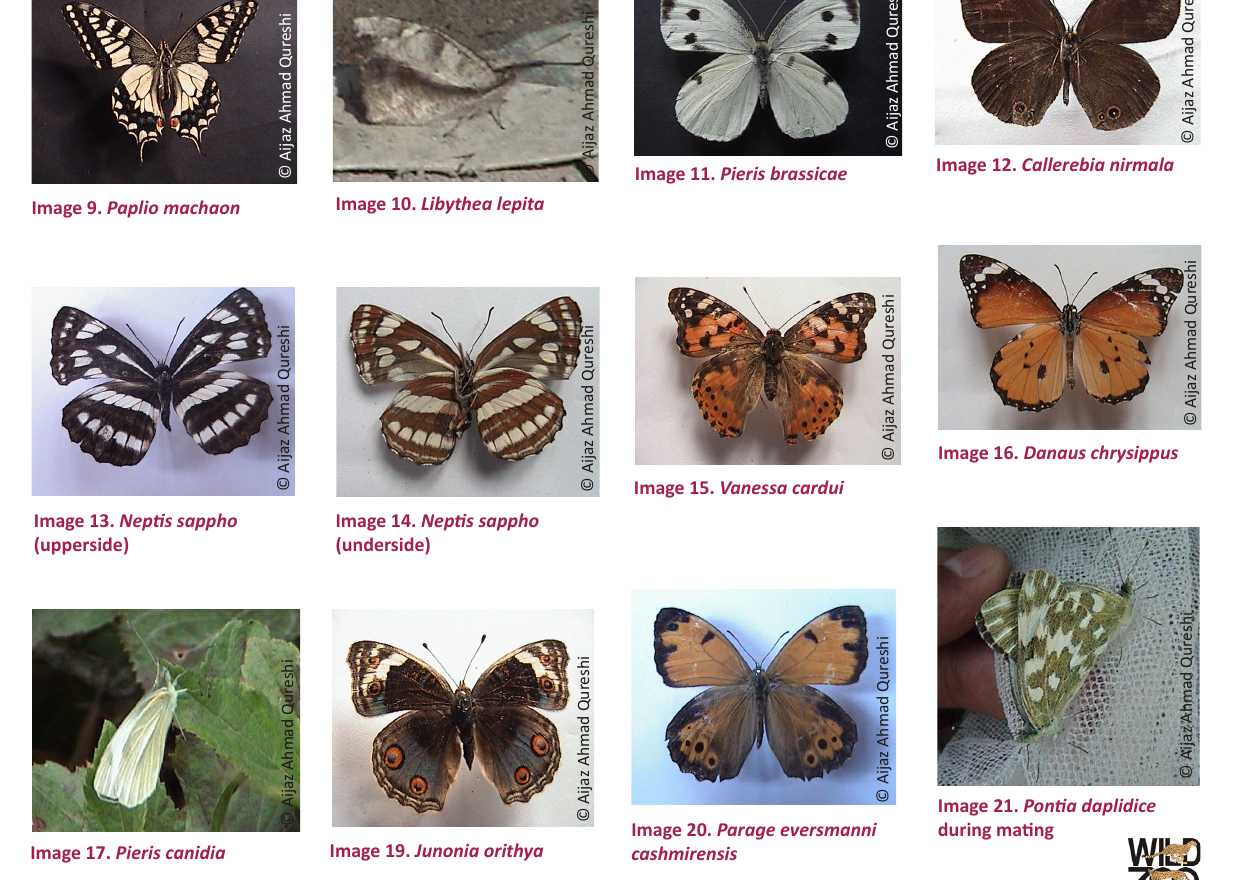
Image 17. Pieris canidia